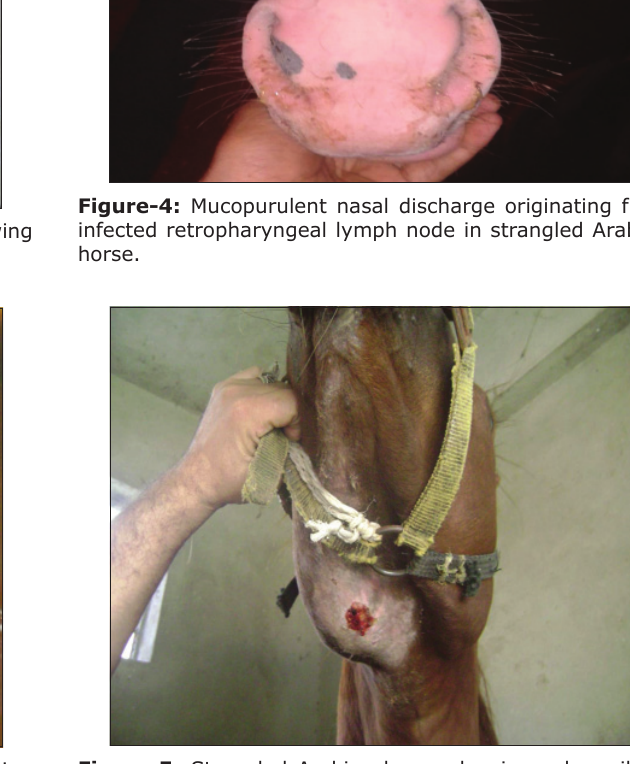
Figure-3: Streptococcus equi on Edward media showing beta-hemolytic dew-drop like colonies.